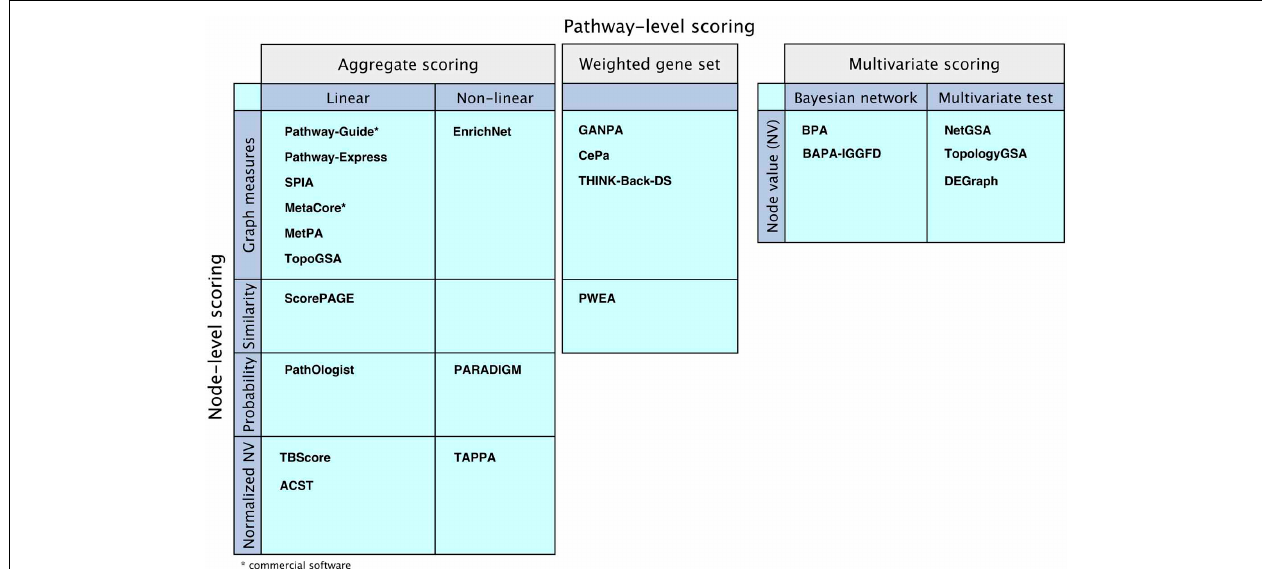
FIGURE 6 | Comparison of the mathematical models of the surveyed pathway analysis methods. “Aggregate scoring” and “Weighted gene set” panels show methods that perform node-level scoring followed by pathway-level scoring performed either as an aggregation of the node scores or as a weighted gene set analysis, using the node scores as weights. The methods are divided according to their node-level scoring methods: graph